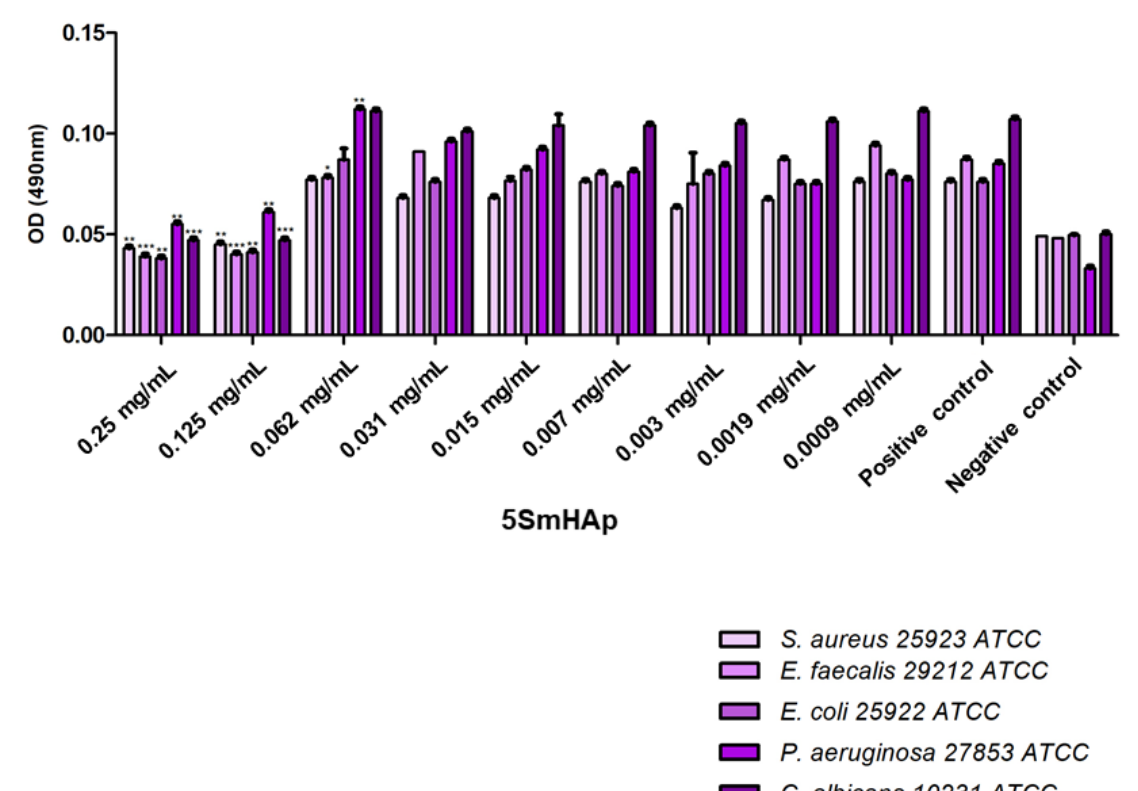
Coatings 2021 , 11 , x FOR PEER REVIEW Figure 5. Graphic representation of the antibiofilm activity of 5SmHAp. * p < 0.05, ** p < 0.01 and *** p < 0.001 compared to control.